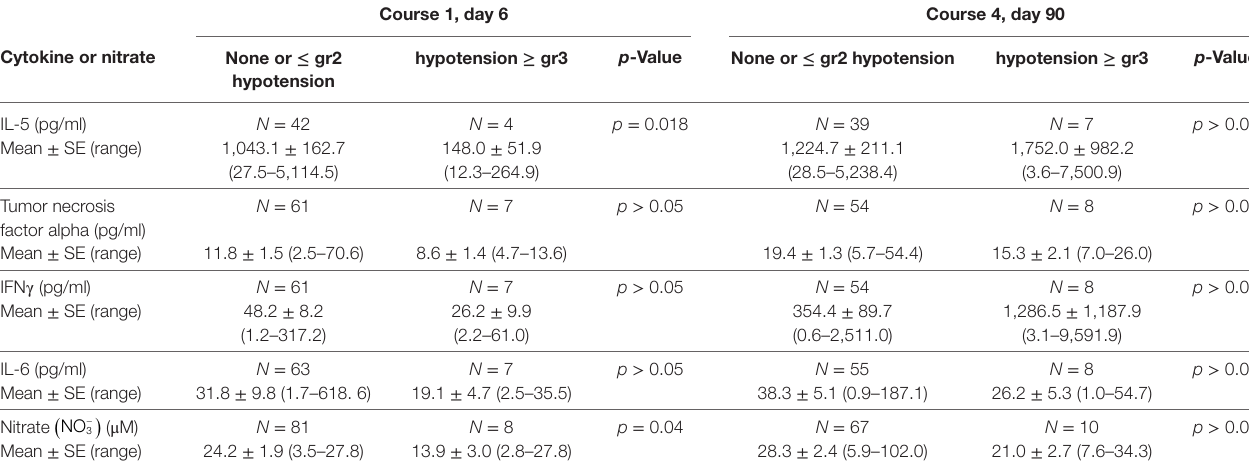
Cytokines or nitrate during course 1 and course 4 of immunotherapy for association with clinically significant ( ≥ grade 3) hypotension. Mann–Whitney U-test comparisons of cytokines were considered significant at a p-value of < 0.0125 after Bonferroni correction for the four cytokines measured at each course. Nitrate levels were considered significant at p = 0.05. ( Table 7 ). No association of any of the cytokines or nitrate with hypotension was observed during the IL-2 containing course 4. Capillary leak incidence varied between 0 and 4% during different courses ( Table 4 ). Nevertheless, in an exploratory fashion, we compared the cytokine and serum nitrate